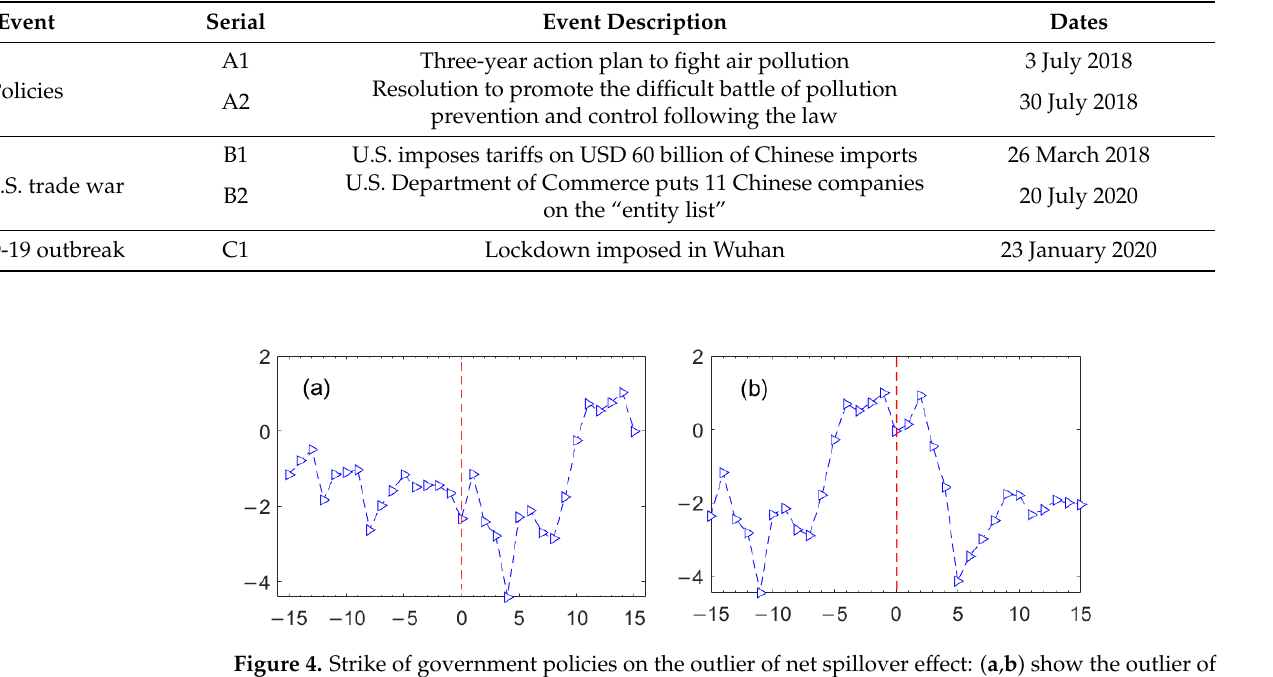
Table 4. Description of the different types of exogenous events.